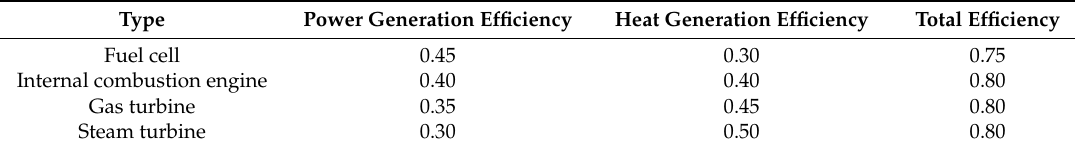
Typical combined heat and power (CHP) system power generation and heat generation characteristics.